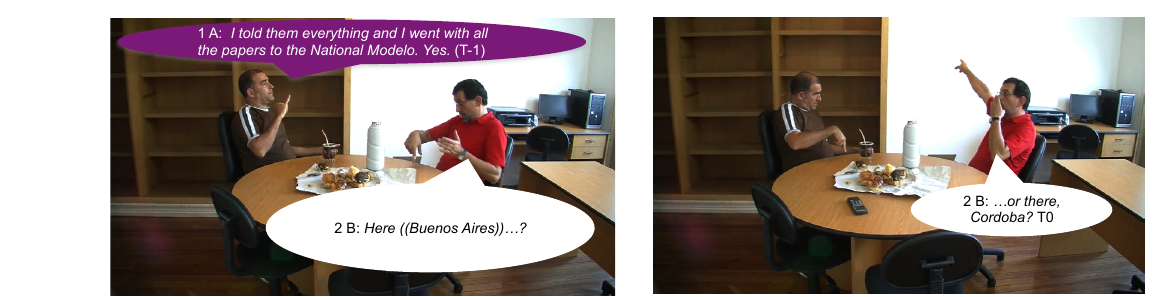
Figure 32. ‘Here…’ , Signer B (right) initiates repair with two pointing signs using his right index finger first in combina- tion with eyebrows raised and head downwards (line 5, first part of the utterance, see next figure).